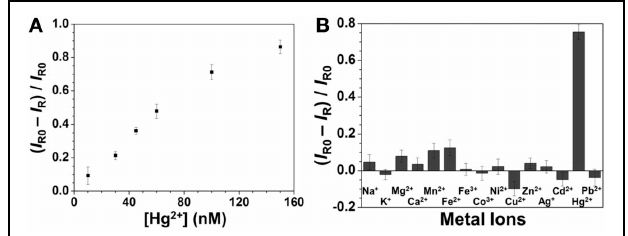
Figure 3 | (A) Sensitivity and (B) selectivity of the SERS approach for Hg 2 + . Concentrations: 100nM for Hg 2 + and 1 µ M for the other metal ions. Reaction time was 10min and pH value was 4.0. The other conditions are the same as in Figure 2 .